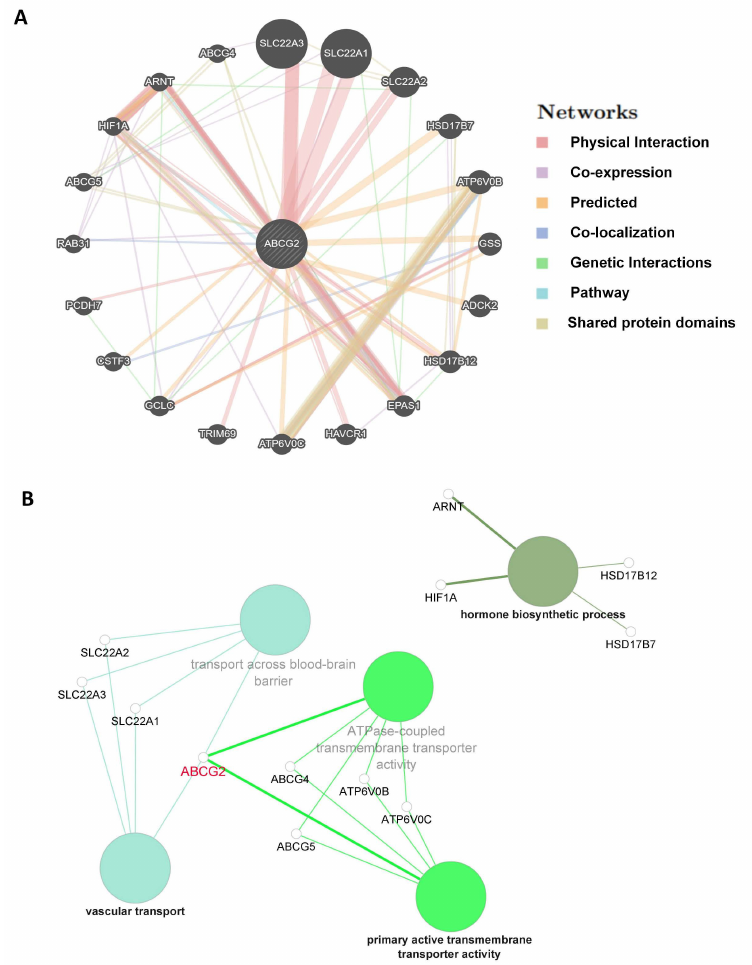
Figure 10. ABCG2-related genes enrichment analysis: ( A ) Protein–protein interaction (PPI) network for the top 20 ABCG2-related proteins based on the GeneMANIA online tool. Different colors of the network edges indicate the bioinformatic methods applied: physical interaction, co-expression, predicted, colocalization, pathway, genetic interaction, and shared protein domains. ( B ) ABCG2 gene and its top 20 related genes were associated to some biological process pathways in GO analysis using Cytoscape. Functionally correlated groups partially overlap and are arbitrarily colored. The node size represents the pathway enrichment